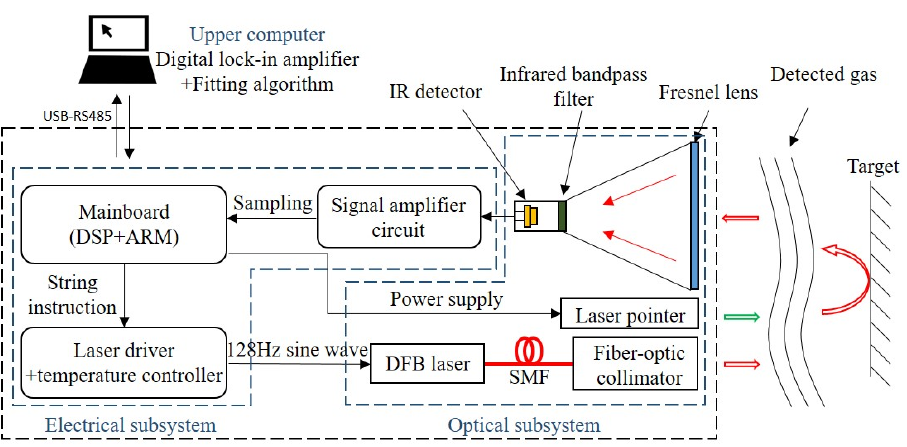
Figure 3. Schematic of the ammonia remote sensor system. This system consists of three parts: an optical subsystem, an electrical subsystem, and an upper computer.